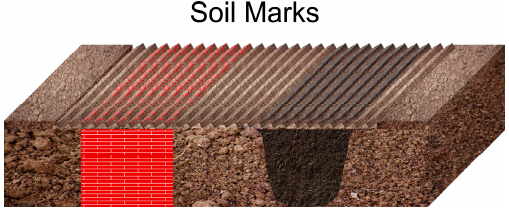
Figure 1. Soil marks: surface residues in bare soil of a buried wall ( left ) and a buried ditch ( right ).